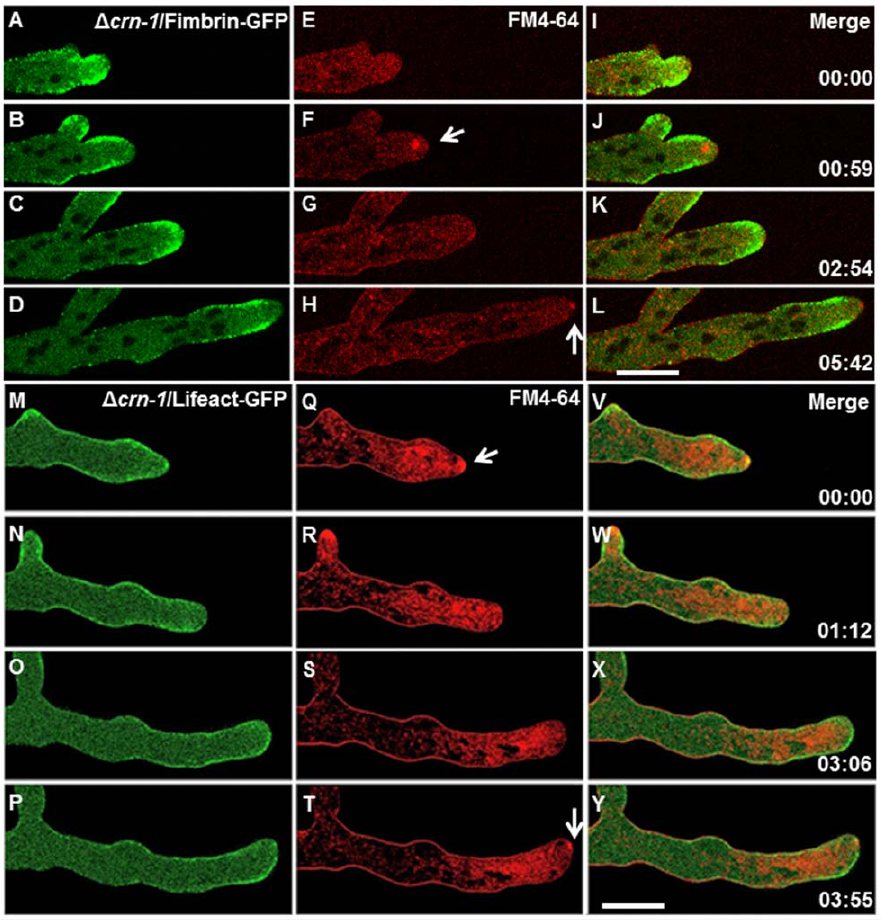
Figure 5. Dynamics of the subapical endocytic collar and Spk behavior in the D crn-1 mutant. (A–L) Subapical endocytic collar of fimbrin, (A–D) Fimbrin-GFP, (E–H) FM4-64 staining and (I–L) merge of Fimbrin-GFP and FM4-64. (M–Y) actin distribution shown with (M–P) Lifeact-GFP, (R–T) staining with FM4-64 and (V–Y) merge of Lifeact-GFP and FM4-64. White arrows point to the presence of the Spk. Time in min:sec. Scale bar=10 m m. Note. The hypha Q–T was exposed to FM4-64 for a longer time prior to the start of the sequence, hence the stronger red signal.